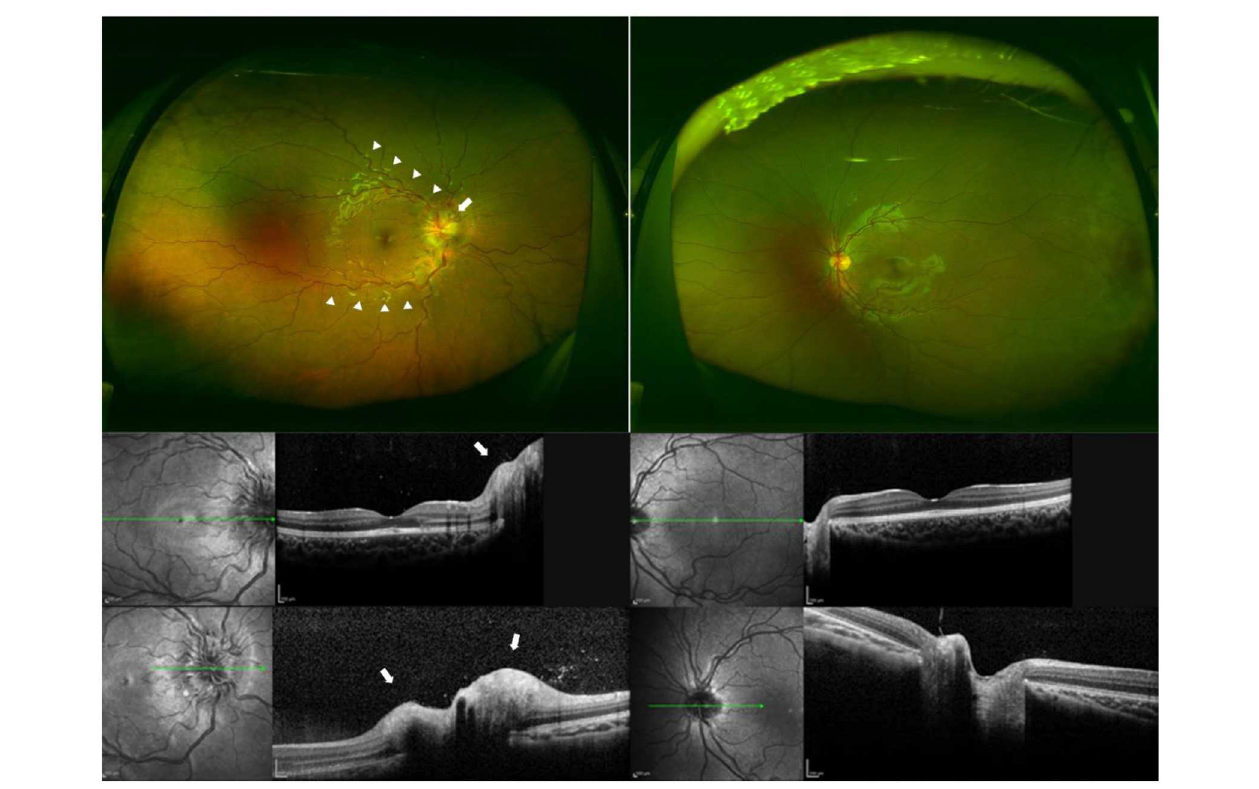
FIGURE 1 | Fundus photographs and optical coherence tomographic (OCT) images of a patient with unilateral optic neuritis and seropositivity to anti-myelin oligodendrocyte glycoprotein (MOG) antibody. (Top) Ultra-widefield fundus photographs of each eye at the initial visit showing tortuous arcade vessels (arrowheads) and optic disc swelling (arrow) in the right eye. The decimal best-corrected visual acuity (BCVA) was light perception in the right eye and 1.2 in the left eye. (Middle) Optical coherence tomographic (OCT) images of the posterior pole of each eye at the initial visit showing optic disc swelling in the right eye (arrow). Left, right eye; right, left eye. (Bottom) OCT images of the optic disc of each eye at the initial visit showing optic disc swelling in the right eye (arrow). Left, right eye; right, left